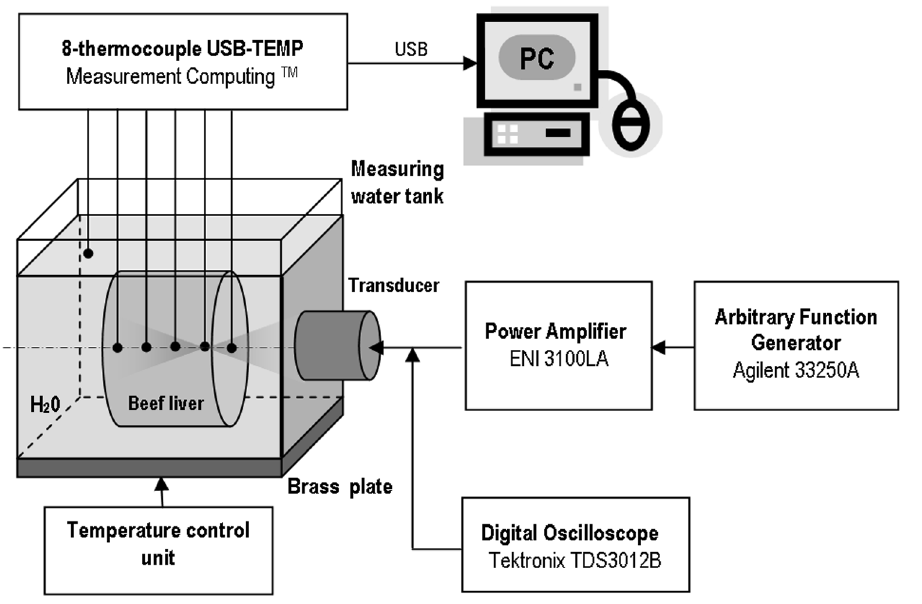
Figure 2. The experimental setup for measuring temperature rises induced in a beef liver sample by pulsed focused ultrasonic beams.